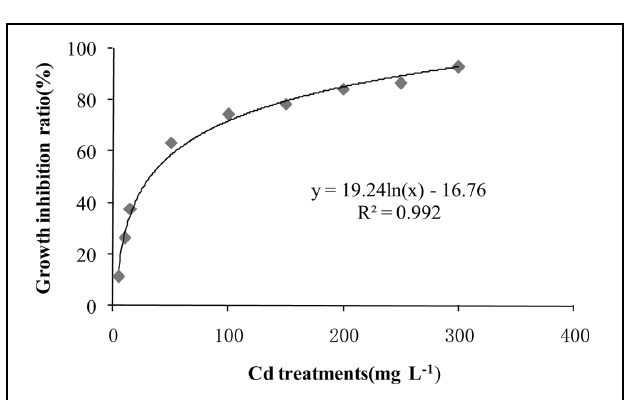
FIGURE 2 | The growth inhibition ratio of T. reesei FS10-C in liquid